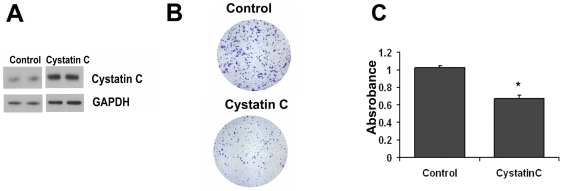
Cystatin C decreases invasion of prostate cancer cells.
A) Immunoblot of cystatin C in PC3 cells after stable transfection with pcDNA3.1 and cystatin C-pcDNA3.1 plasmids. Stable clones were established after 2 weeks of selection on neomycin. B–C) Invasion assay of PC3 cells with overexpression of control or cystatin C plasmids. Representative images of cells are shown in B and quantification (absorbance) of data +SD from 3 independent experiments is shown in C. *p<0.05 (Student T-test).